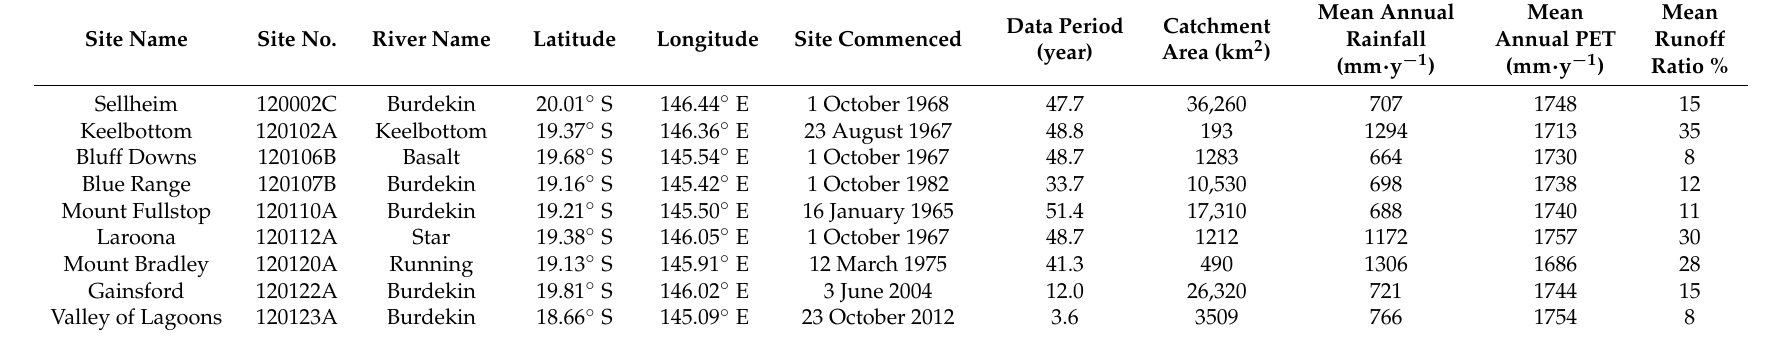
Table 1. Characteristics of the currently operational stream gauging stations in the Upper Burdekin